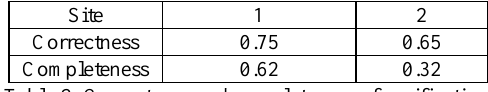
Table 2. Correctness and completeness of verification